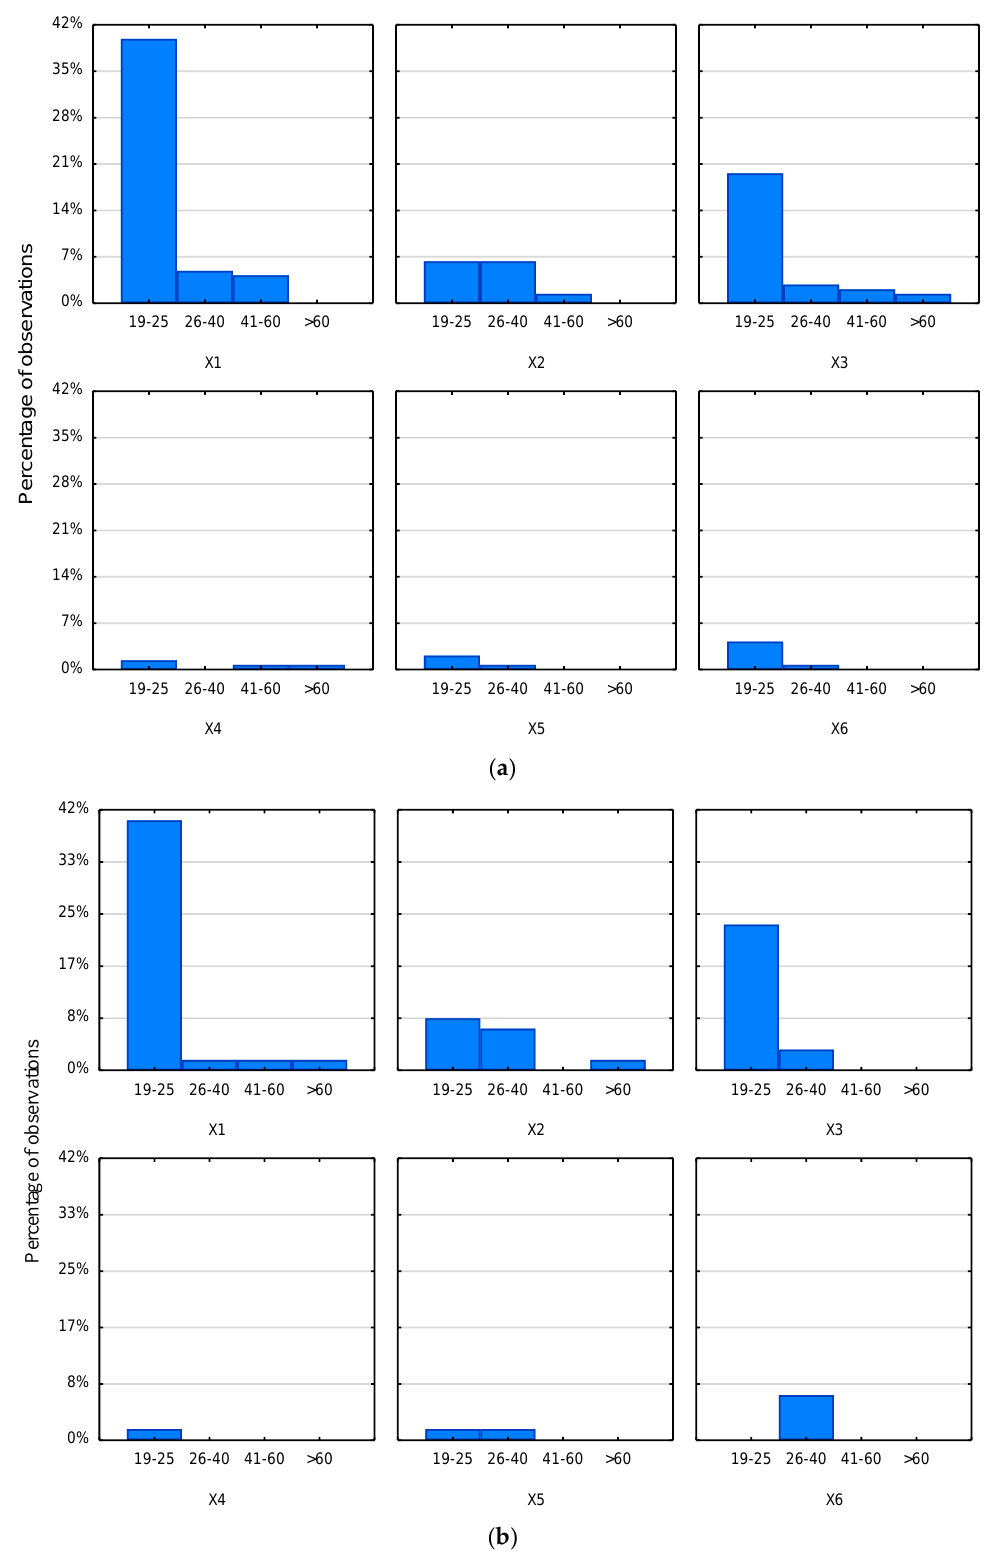
Figure 3. ( a ). Places of women’s daily food shopping. Histogram categorized by the variable age. ( b ). Places of men’s daily food shopping. Histogram categorized by the variable age. Abbreviations: X1, hypermarket; X2, via internet; X3, local store; X4, wholesale; X5, farmer; X6, marketplace; 19–25 years; 26–40, 26–40 years; 41–60, 41–60 years; >60, more than 60